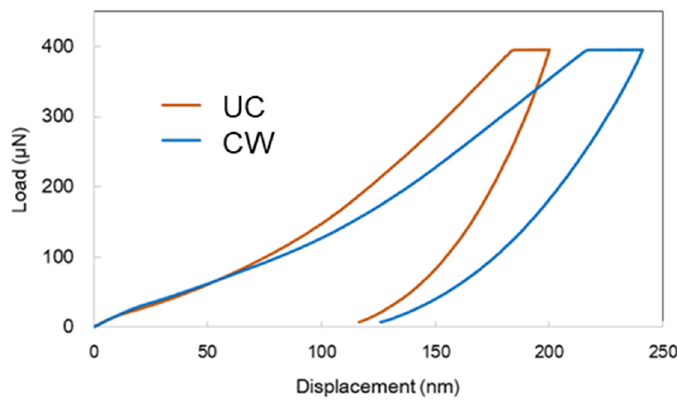
Figure 4. Typical NI load-displacement curves of ancient wood and undegraded contemporary wood.